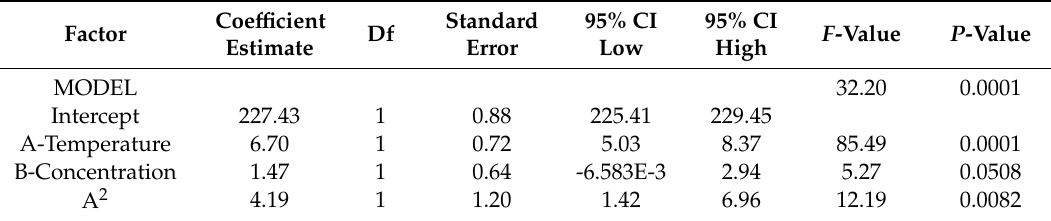
Table 11. Modified quadratic model regression coe ffi cients and statistical analysis.